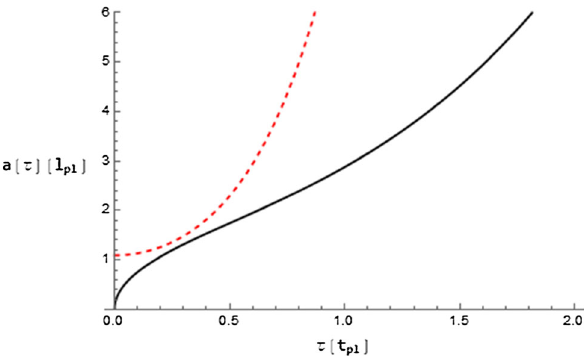
Fig. 1 The figure shows the comparison between the solutions of the Friedman equation with (continuous line) or without (red dotted line) the presence of a Schutz fluid. Boththe cases describe a closedUniverse in which there is a cosmological constant ( Λ